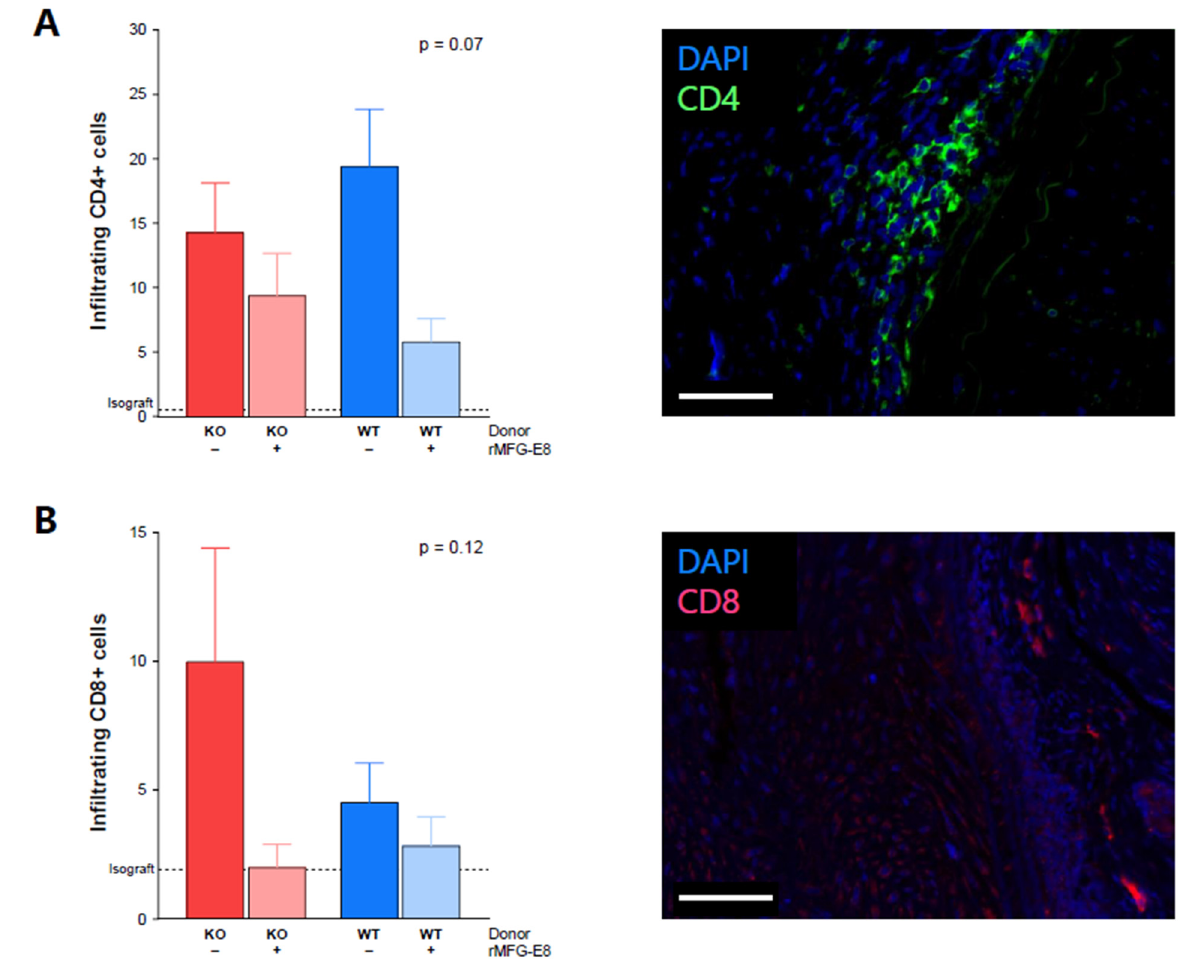
Figure 3. Effect of MFG-E8 on T-cell allograft infiltration. ( A ) CD4 + cell infiltration within the transplanted aorta, assessed by immunofluorescence (green staining). ( B ) CD8 + cell infiltration within the transplanted aorta, assessed by immunofluorescence (pink staining). Values represent the average number of positive cells in three random areas. All data were assessed 9 weeks after transplantation. White bars represent 50 µ m. p -Value (upper right corner) indicates the overall ANOVA result.